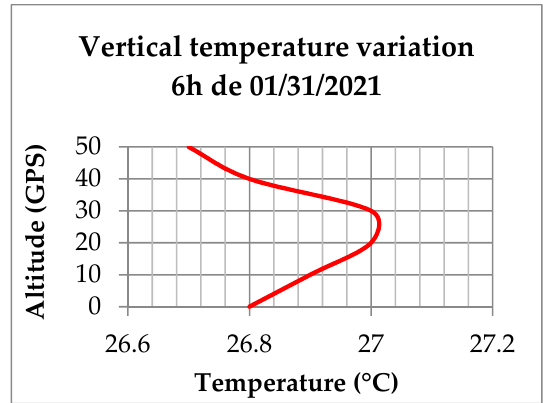
Figure 8. Vertical temperature at 6 a.m.